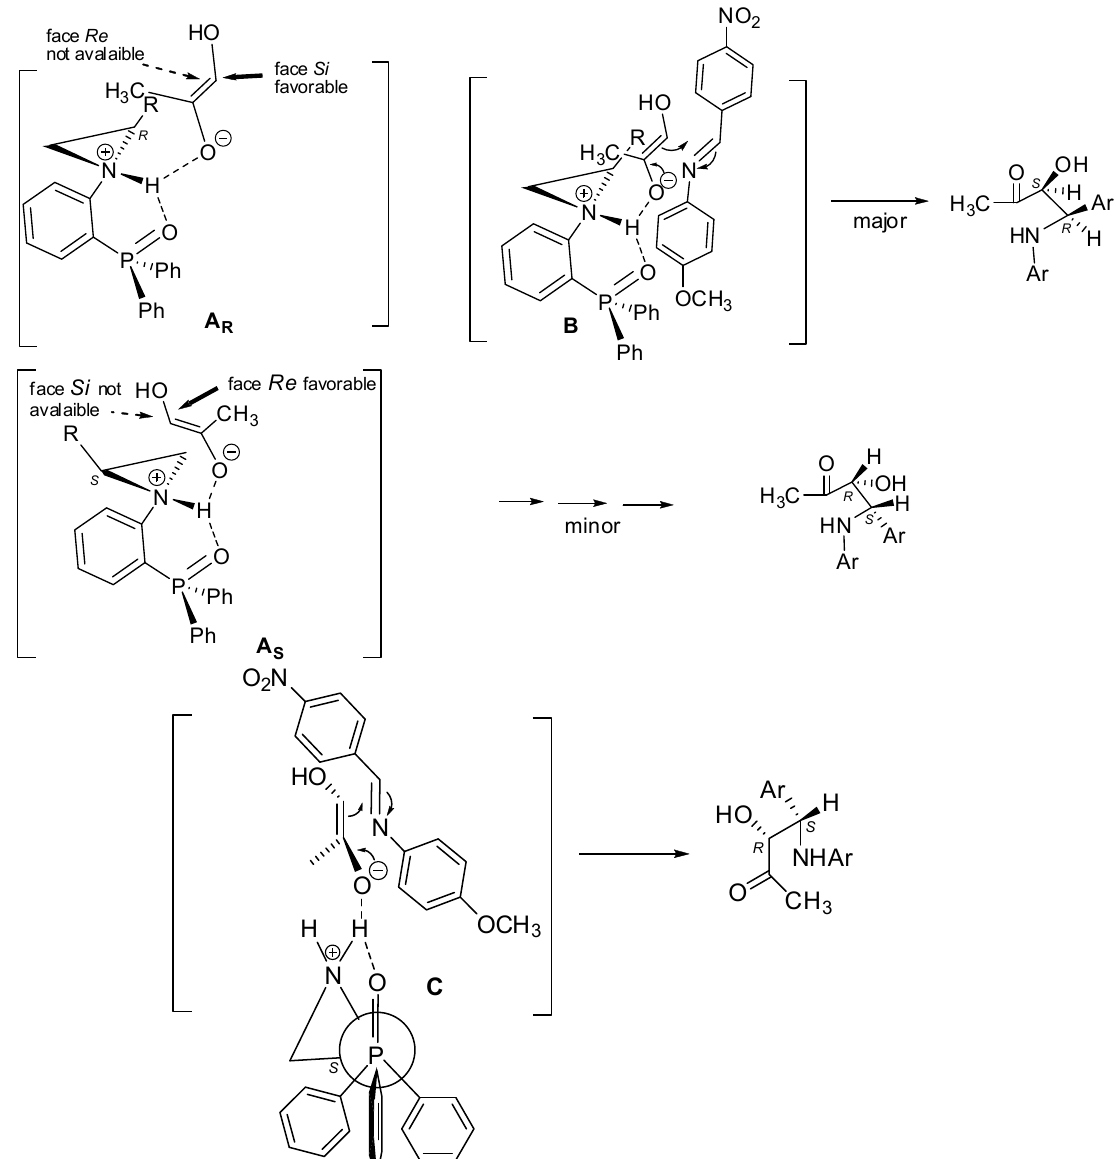
Figure 2. Tentative transition state model.